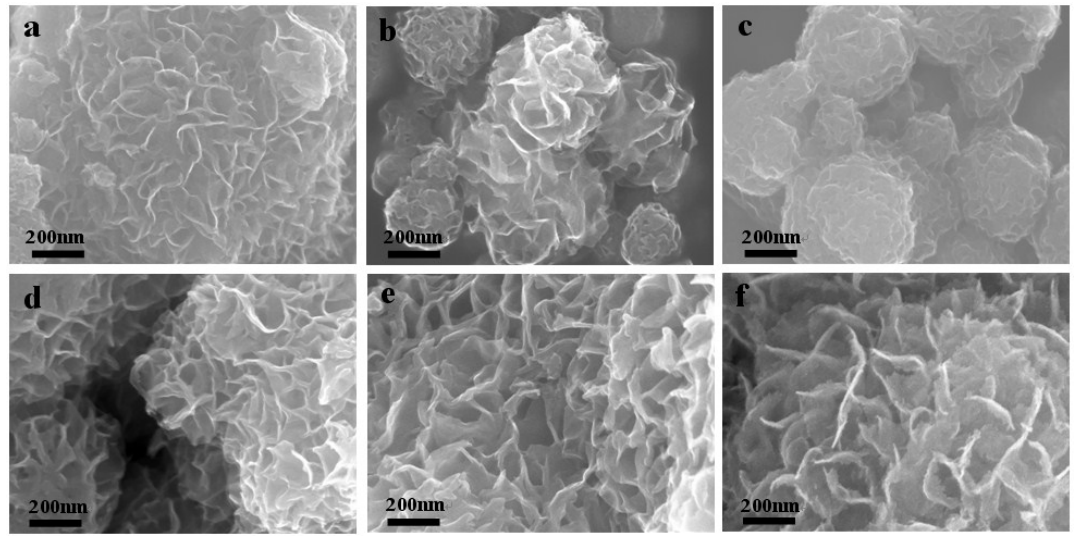
Figure 4. Scanning electron microscope (SEM) images of ( a ) pure MoS 2 ; ( b ) MoS 2 /PVA–0.04 composite; ( c ) MoS 2 /PVA–0.08 composite; and ( d ) MoS 2 /PVA–0.4 composite.